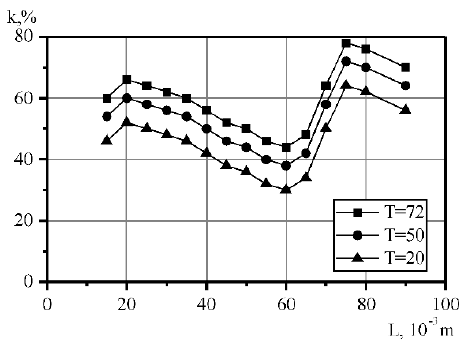
Figure 3. Milk homogenization coefficient versus the distance between the nozzle and the obstacle curve, when n = 6: 1—20 °C, 2—50 °C, 3—72 °C. Table 1. Mechanism of milk fat dispersion. Turbulent drop dispersion: isotropic and viscous. The mechanism of isotropic disper- sion turbulence is followed by the stress fluctuations caused by the microvorticity.